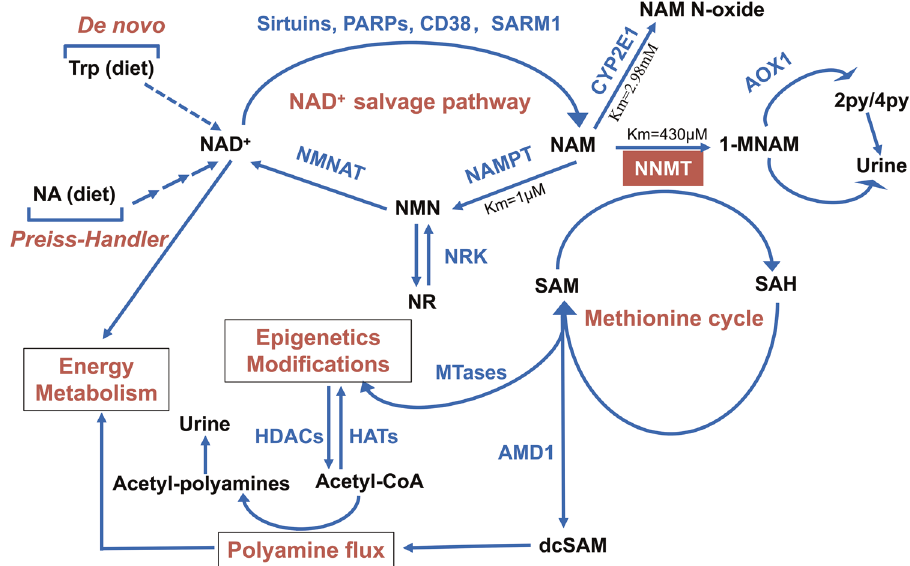
Fig. 3 Metabolic processes mediated by NNMT. NAM is N-methylated by NNMT consuming the universal methyl donor SAM. The methylated product 1-MNAM is further oxidized by AOX1 into two related compounds 2py and 4py. All three metabolites are eventually excreted in the urine but the major urinary metabolites are 1-MNAM and 2py, accounting for 20 – 35% and 45 – 60%, respectively. When NAM is at an acute pharmacological dose, it is mainly converted to NAM N-oxide by CYP2E1. NAM is a crucial precursor for NAD + , which is one of the most abundant molecules in the human body, needed in ~500 different enzymatic reactions and present at about three grams in the average person. It can be synthesized from several distinct dietary precursors through three separate pathways, de novo, Preiss – Handler, and salvage pathways. SAM donates methyl groups for epigenetics modi fi cations as well as provides propylamine groups in polyamine fl ux. AMD1 uses SAM to generate dcSAM for synthesizing spermidine and spermine. Then, SSAT takes acetyl-CoA as a substrate to acetylate spermidine and spermine and form acetylpolyamine. SAM and acetyl-CoA are substrates for histone methylation and acetylation and as a result, levels of SAM or acetyl-CoA may affect epigenetics modi fi cations. Trp tryptophan, NAM nicotinamide, NA nicotinic acid, dcSAM decarboxylated SAM, 2py N 1-methyl-2-pyridone-5-carboxamide, 4py N 1-methyl-4-pyridone-3-carboxamide, NAMPT nicotinamide phosphoribosyltransferase, NMNAT nicotinamide mononucleotide adenylyl transferases, NRK nicotinamide riboside kinase. PARPs poly (ADP-ribose) polymerases, MTases methyltransferases, HATs histone acetyltransferase, HDACs histone deacetylases, AMD1 adenosylmethionine decarboxylase, AOX1 aldehyde oxidase 1, SSAT spermidine-spermine N 1-acetyltransferase, PARPs poly [ADP-ribose] polymerases, SARM1 sterile alpha and Toll/interleukin-1 receptor motif-containing protein